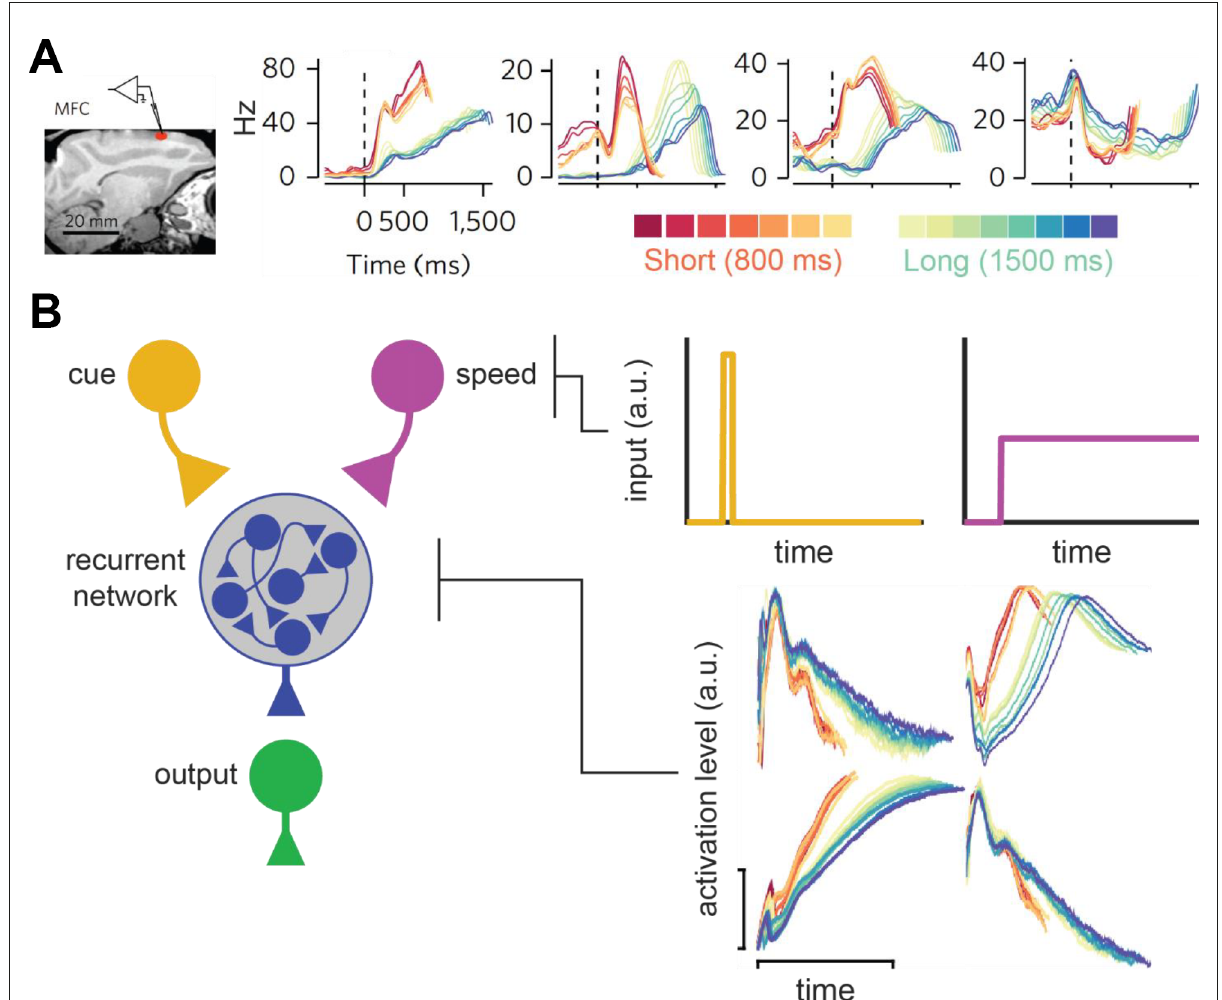
FIGURE8 Temporal scaling in Wang et al. (2018). (A) Temporal scaling in neural data. Left: Electrode placement in medial-frontal cortex in Wang et al. (2018) study. Firing profiles of neurons at the recording site that displayed temporal scaling, split by both interval (short = red-hued/long = blue-hued) and within-subject variance for each interval (see color bars at the bottom). All figures adapted from Wang et al. (2018). (B) Wang et al.’s (2018) neural network model of temporal scaling. Left: Model-schematic. Users send a cue-pulse and tonic (i.e., speed) input to the recurrent network, which converges on the output node. Right: Profiles for the cue and tonic user-inputs (top two panels) and representative scaling activity in the recurrent layer adapted from Wang et al.